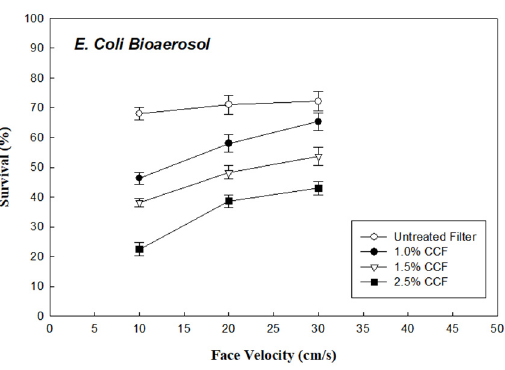
Figure 3. Survival of E. coli bioaerosols through the chitosan-coated and untreated filters. The penetration (P Std ) of the PSL aerosol through the CCFs revealed that the elec- trostatic force increased when the filter was coated with chitosan. In the filtration of the E. coli bioaerosol using CCFs, the enhanced electrostatic force and antimicrobial effects were added to the original capture force from the untreated filter. Accordingly, 28% of the variations in the survival (R Ec = 23%, 2.5% CCFs under face velocity 10 m/s) of the E. coli bioaerosol and the PSL aerosol penetration (P Std = 51.1%, 2.5% CCFs under face velocity 10 m/s) through the CCFs were attributed to the antibacterial effect of the filter pretreated with chitosan. In addition, the differences between R Ec of the E. coli bioaerosol and the PSL aerosol penetration (P Std ) through the 1.0%, 1.5%, and 2.5% CCFs were approximately 13%, 17%, and 28%, respectively. The experimental results reveal that a higher concentration of CCFs corresponds to a decrease in E. coli bioaerosol survival, resulting in a larger differ- ence between E. coli (R EC = 46% and 23% on 1.0% and 2.5% CCFs, respectively) and PSL (P Std = 58.9% and 51.1% on 1.0% and 2.5% CCFs, respectively). These findings could Figure 4. Survival of B. subtilis bioaerosols through the chitosan-coated and untreated filters.